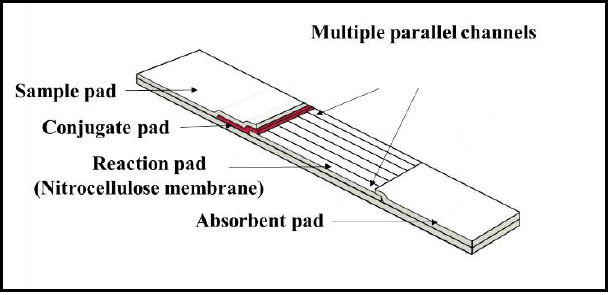
Figure 1. Schematic of a multiple (six) flow-path lateral flow device (LFD).